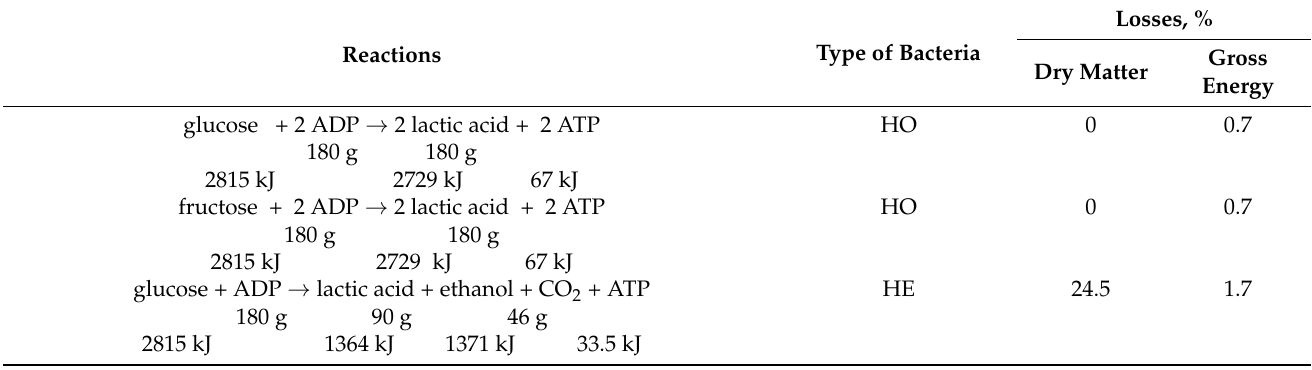
Table 2. Examples of lactic fermentation reactions occurring in ensiled forages along with the balance of DM and gross energy